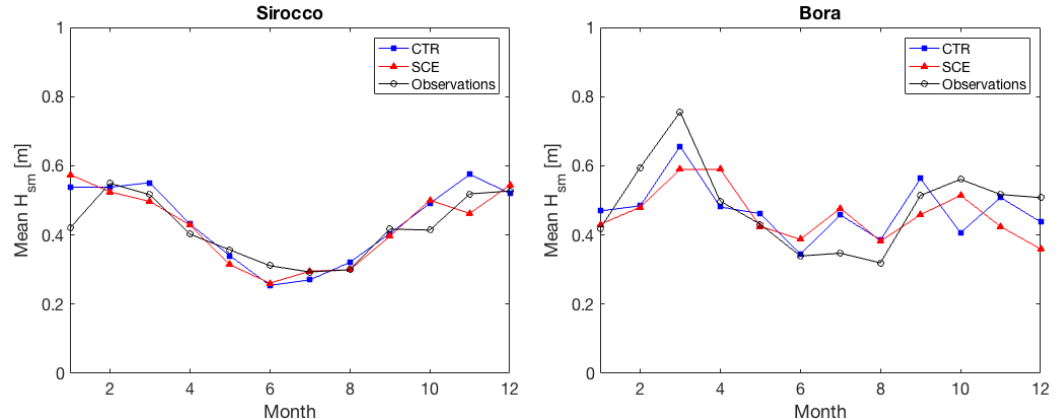
Figure 3. Monthly averages of the significant wave height H s,m offshore of the study area of Lido di Spina that resulted from CTR (1971–2000) and SCE (2071–2100) scenarios performed by SWAN implementation [34] and from NAUSICAA—transposed observations (2007–2017) for Sirocco ( left panel ) and Bora ( right panel ) events.